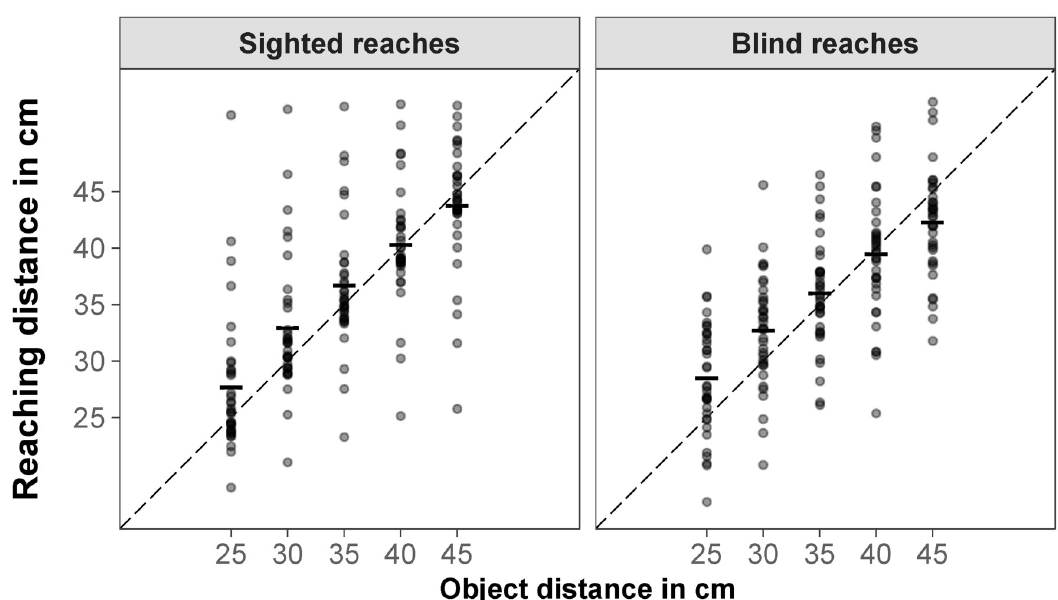
Fig 9. Reaching distance in congruent trials. Mean sighted and blind reaches for object distance; each data point represents the median for one participant (aggregated over six objects); the dashed black line represents the object distance as specified by binocular disparity and familiar